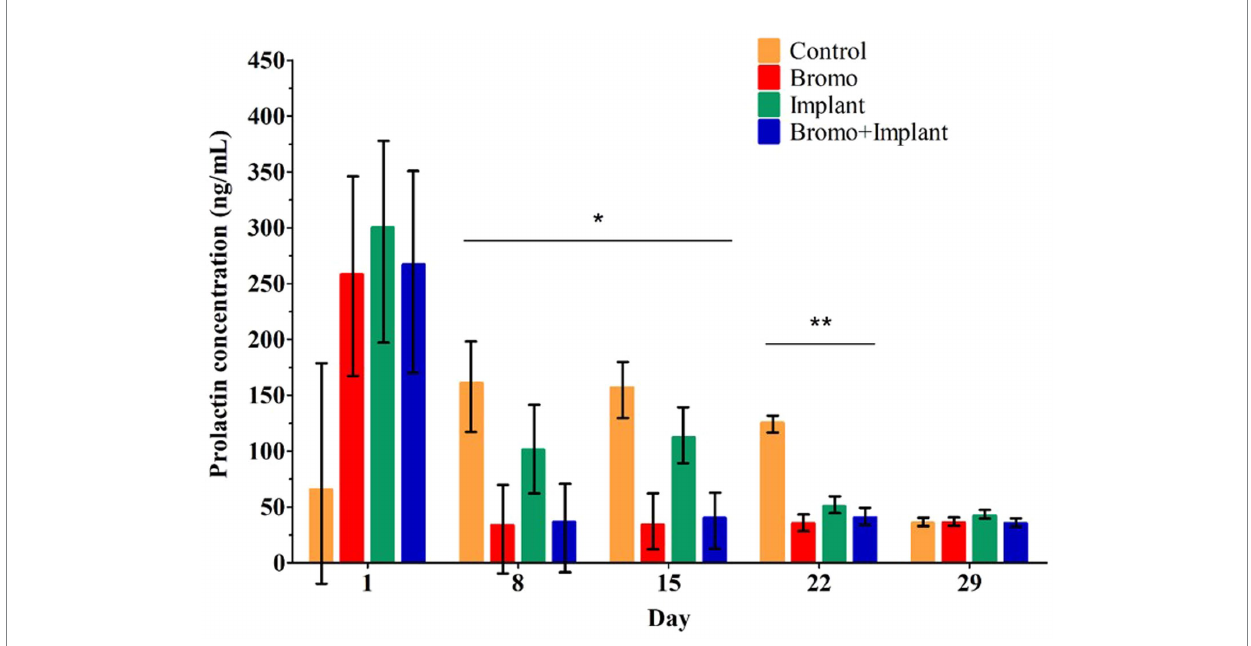
FIGURE 1 Mean plasma concentrations of prolactin (ng/mL). Values are means ± SE of plasma prolactin concentrations for steers treated with bromocriptine injections and estradiol/TBA implants from weekly samples over 29 days. Day 1 represents sample taken immediately before treatment administration. Days denoted with *show bromocriptine treatment significantly decreased prolactin (Day 8, p = 0.04; Day 15, p = 0.001). Days denoted with **show bromocriptine treatment significantly decreased prolactin ( p = 0.002), implantation significantly decreased prolactin ( p = 0.02), and a bromo x implant interaction ( p = 0.01). Data for each day analyzed as a randomized complete block, terms of the model included bromo, implant, and their interactions, in a 2×2 factorial structure. Control n = 6: Bromo n = 8; Implant n = 7; and Bromo+Implant n =